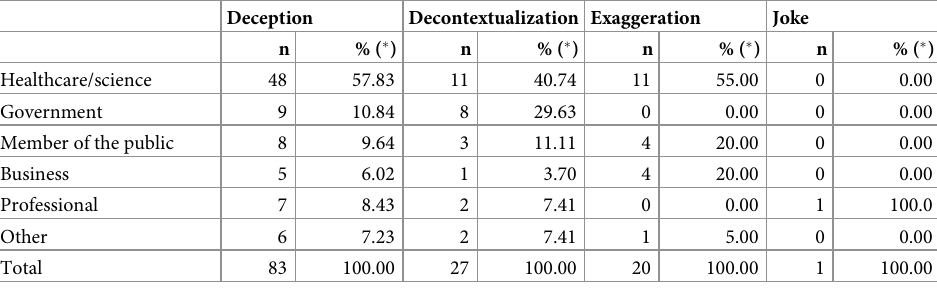
Table 12. Non-anonymous source types by hoax